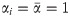
Ultrasensitivity of MWC system.(a) Dose response curve, f(u, c, α), when n = 2, 4, and 8 for increasing u with ci = 0.01, αi=α¯=1 and L = 1000. (b-d) Heat maps for H when c1, c2 ∈ [10−4, 0.9] with L = 1000 and αi=α¯=1 and (b) n = 2, (c) n = 4, ci = 0.01 for i ≥ 3, similarly with (d) n = 8. White indicates undefined H values.